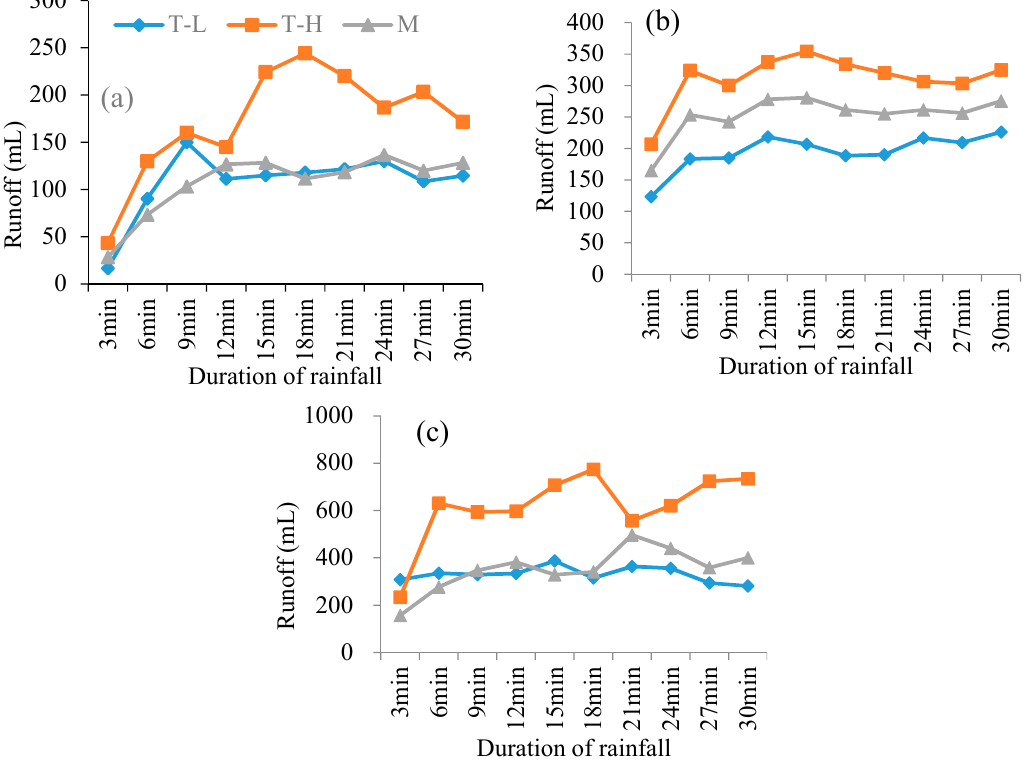
Figure 3. Runoff changes under different surface landscape conditions. ( a ) 30 mm/h rainfall intensity; ( b ) 75 mm/h rainfall intensity; and ( c ) 120 mm/h rainfall intensity. T-L stands for thin litter layer with low soil bulk density, T-H stands for thick litter layer with high soil bulk density, and M stands for moderate litter depth and soil bulk density.